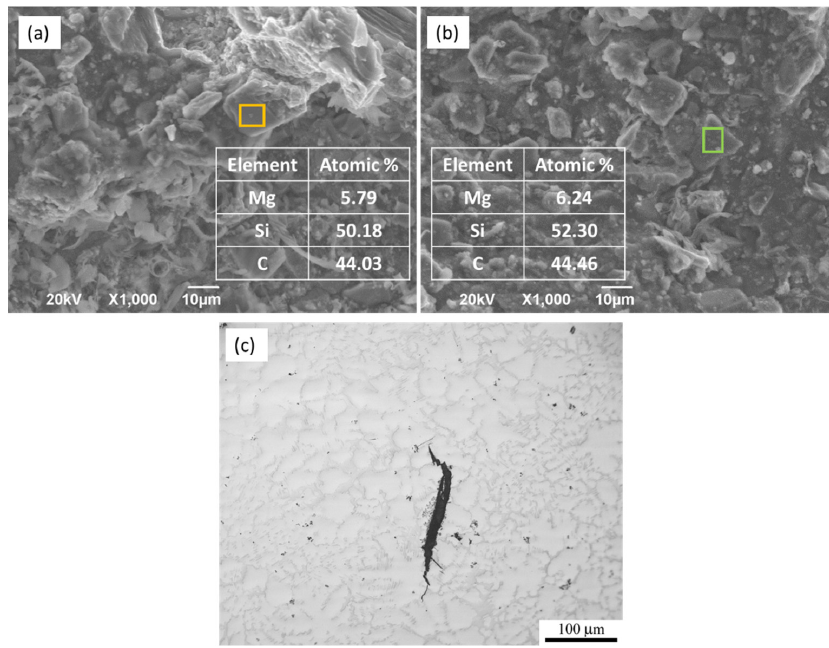
Figure 5. Fracture morphologies under higher magnification showing clustering of SiC particles: ( a ) WZ73-1.5 vol% SiC and ( b ) WZ73-2.5 vol% SiC; ( c ) Optical microscope (OM) showing clustering of particles is favorite for crack formation.